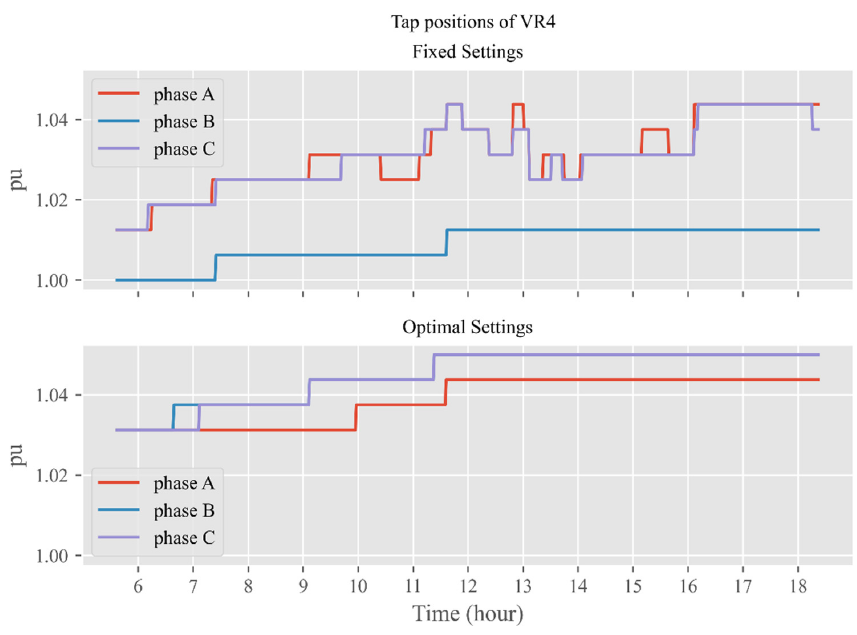
Figure 16. Three-phase tap positions of VR4.